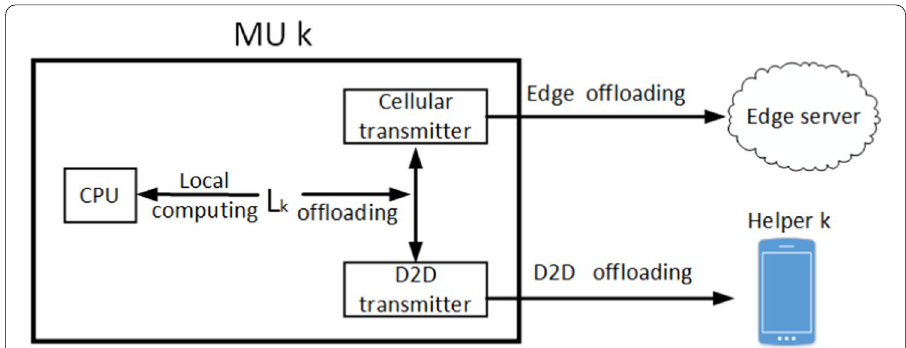
Fig. 2 Computing